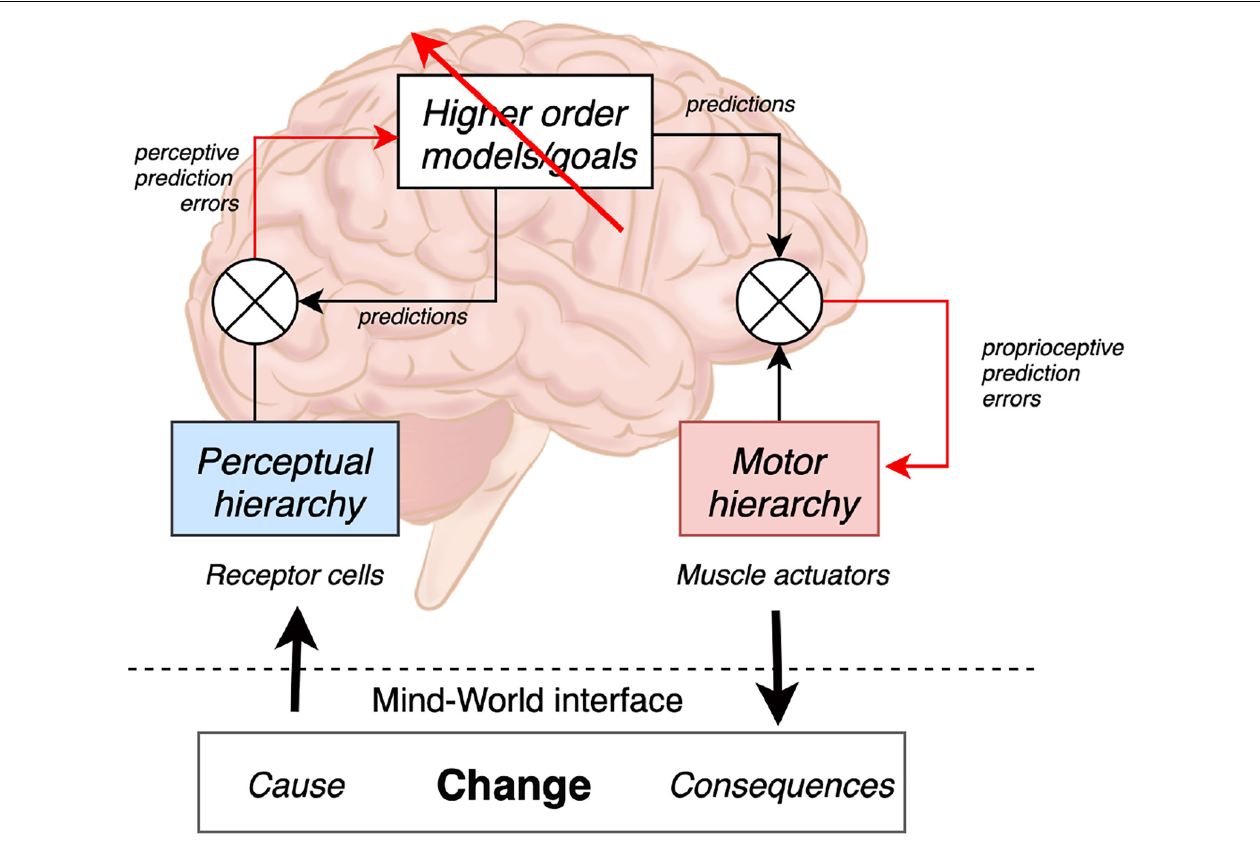
FIGURE 1 | Perception models afferent changes in states of the world detected by receptor cells (e.g., in the retina) all along the perceptual hierarchy. In this control diagram, N denotes a comparator. The red arrows denote inference and learning (i.e., driven by prediction errors) that compare (descending) predictions with (ascending) sensations. Cognition and higher order processing attempt to predict sensory input and futures states of the world based on available (generative) models; thereby, minimizing prediction error. Action organizes the motor hierarchy in an attempt to actively control the efferent consequences of ongoing events; namely, by modifying causes anticipated through perceptual means, thereby altering the system’ dynamics to make them more predictable (i.e., less surprising). Though not specified on this diagram, perception can be further subdivided into interoception and exteroception; respectively, modeling changes in the internal and external world. Emotion–and related notions of selfhood–usually arise via predictive processing of interoceptive sensations, often known as interoceptive inference (Seth, 2013, 2014; Seth and Friston,